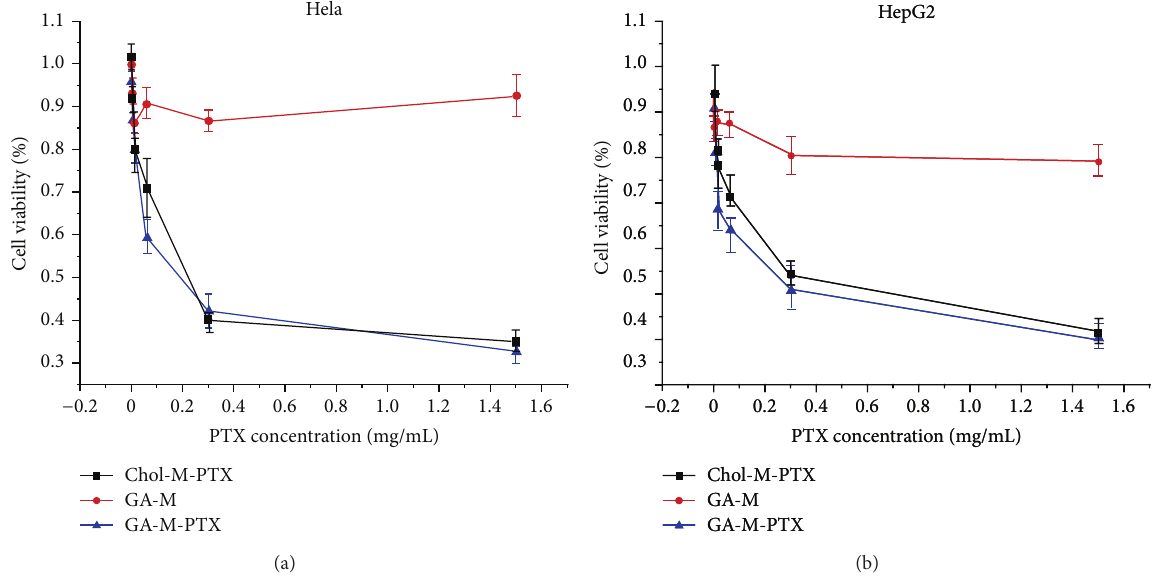
Figure 6: Cytotoxicity of Chol-M-PTX ( ◼ ), blank micelles ( ∙ ), and GA-M-PTX ( 󳵳 ) on Hela (a) and HepG2 (b) cell lines. The percentage of viable cells was quantified using the MTT method. Mean values and 95% confidence intervals derived from three independent experiments are shown. 𝑃 < 0.05 .